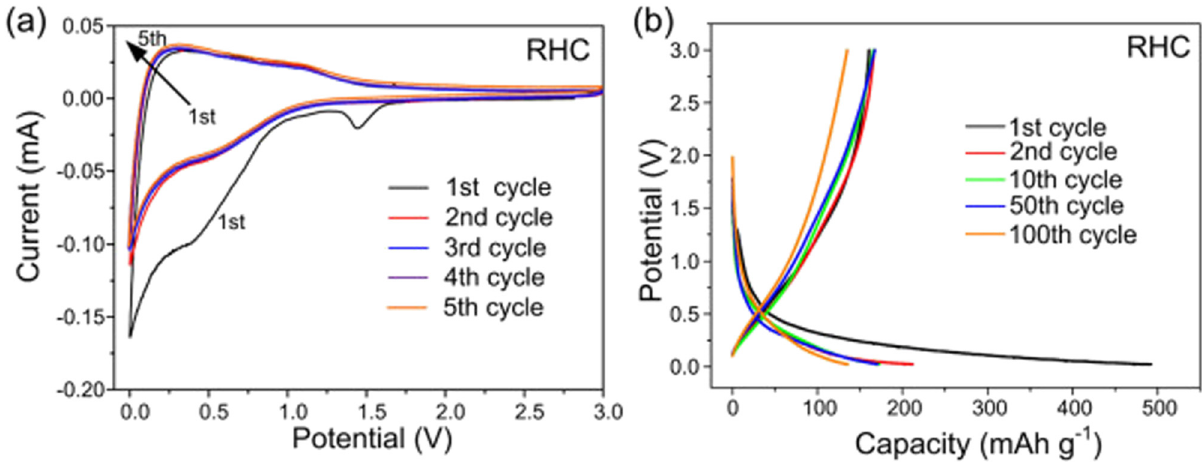
Figure 40: ( a ) CV and ( b ) charge – discharge curves of an electrode obtained from rice husk. Adapted with permission from ref. [ 372 ] ; Elsevier,